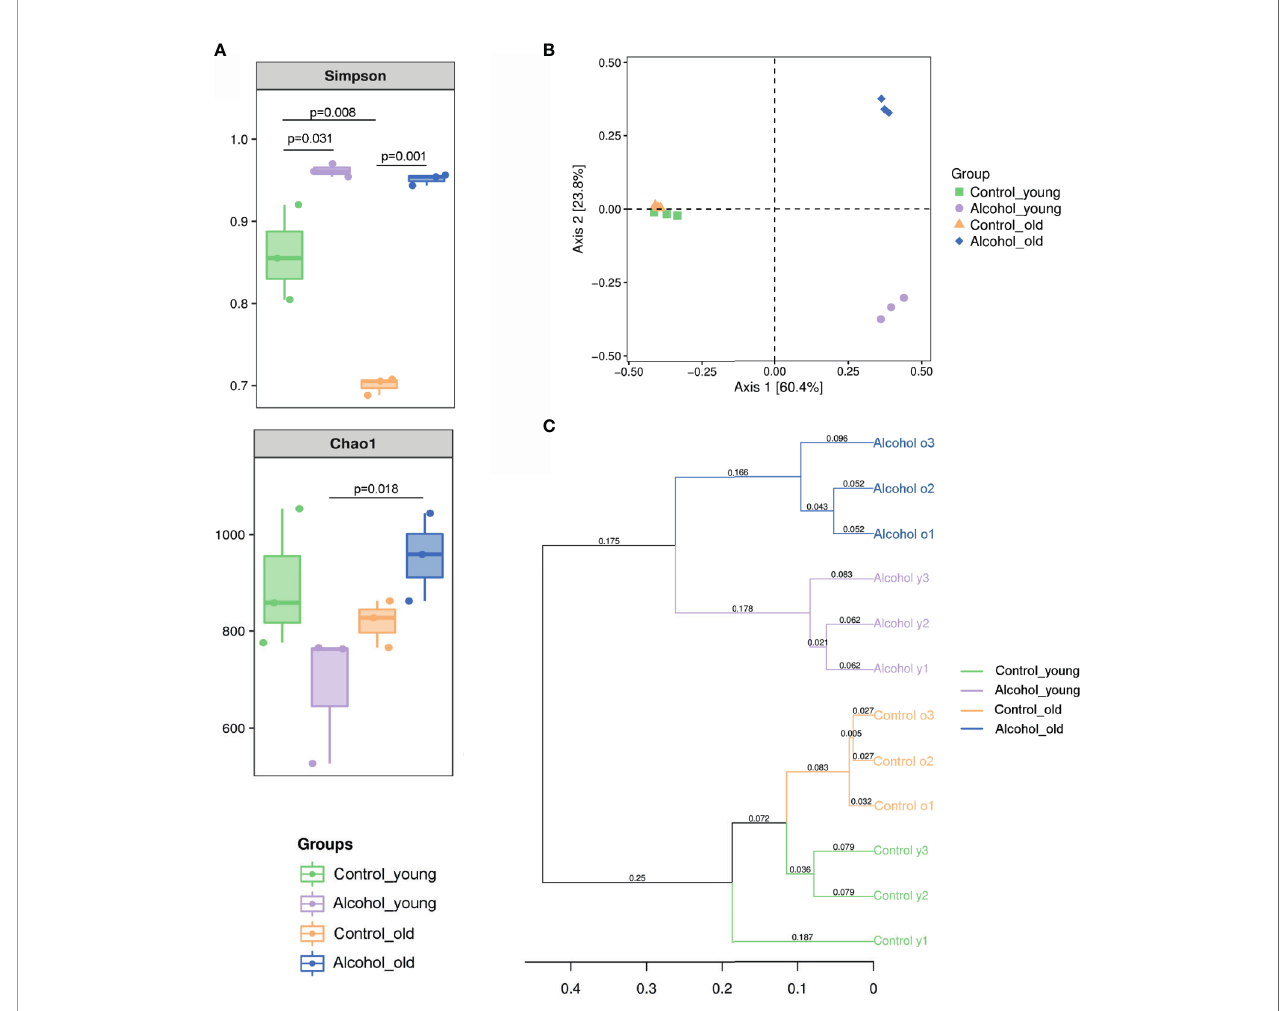
FIGURE 5 | Richness and diversity of fecal microbiota. (A) The a diversity of fecal microbiota in rats; (B) PCoA analysis of Bray-Curtis distances within PC1 and PC2 axes in rats; (C) UPGMA cluster analysis based on Bray-Curtis distance in rats. n =